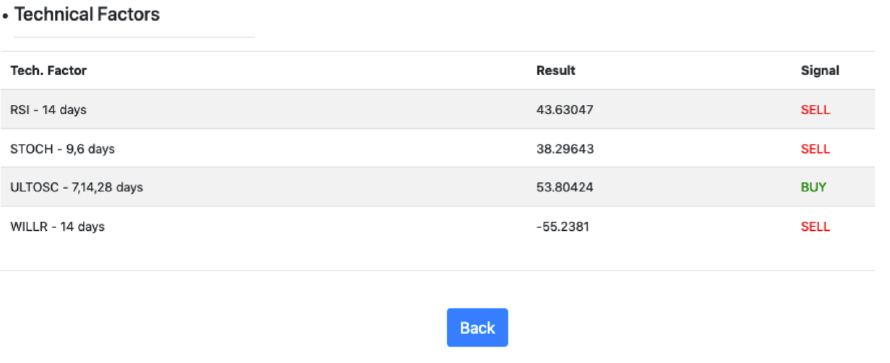
Figure 19. Buy/sell